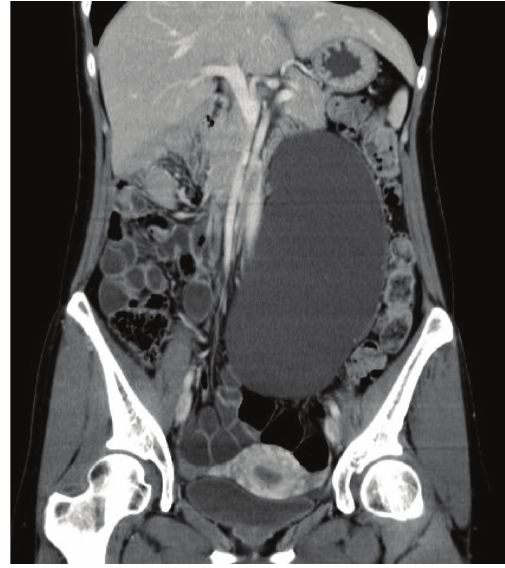
Figure 1: Coronal section of abdominal CT demonstrating a large water density occupying much of the left retroperitoneal space.